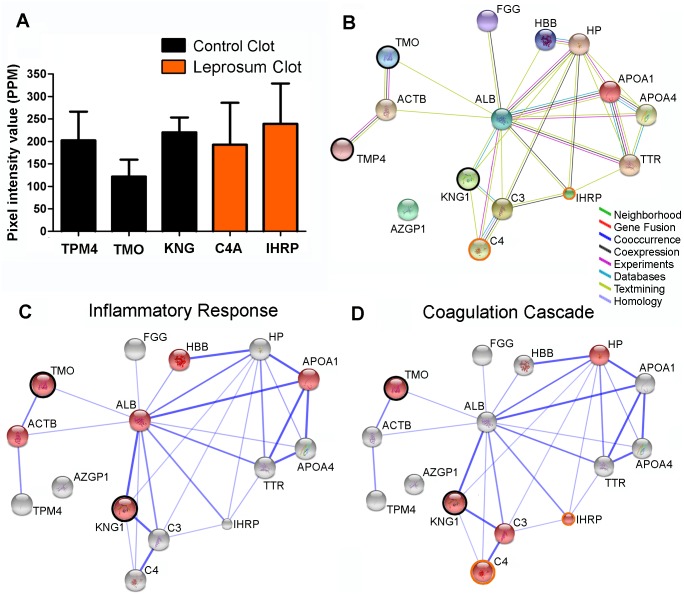
Protein-protein interaction network constructed by STRING 10.(A) Protein differential identification by 2DE in control (CC) and leprosy clots (LC). Pixel intensity value in PPM for each protein. Black bars represent proteins exclusively identified in CC: TPM4 (tropomyosin alpha-4), TMO (tyrosine 3-monooxygenase) KNG1 (kininogen 1), and orange bars represent proteins identified only in LC: C4A (complement component 4A) and IHRP (inter-alpha-trypsin inhibitor family heavy chain-related protein). (C) Confidence view based on the Gene Ontology enrichment to biological processes related to blood coagulation (p = 1.469−3); (B) Evidence view showing all detected proteins in both clots by different line colors representing the types of association evidence (only associations with p = 1.98−13 are shown); (C) and inflammatory response (p = 6.369−4). Stronger associations are represented by thicker lines. IHRP is represented by a small sphere, indicating that there is no crystallographic data about its structure. Proteins highlighted by black rings were exclusively detected in control clots, and proteins highlighted by orange rings were exclusively detected in leprosy clots.